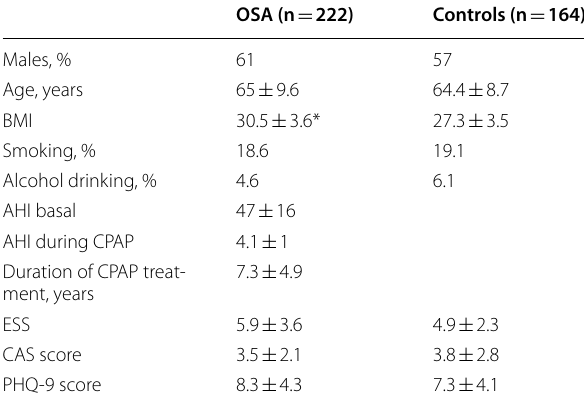
Table 1 Demographic and clinical data of the study groups